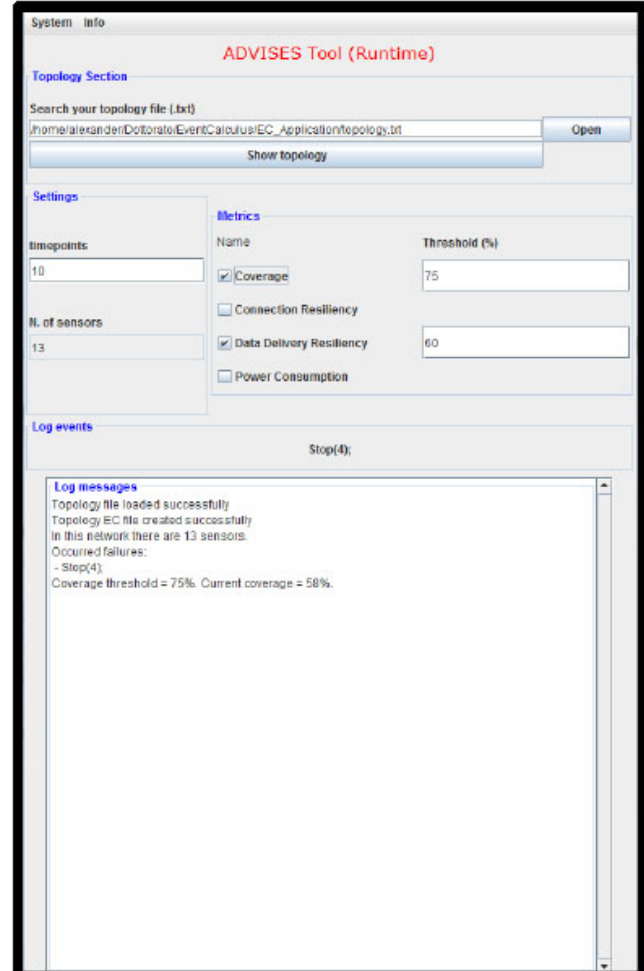
Figure 8. ADVISES in runtime